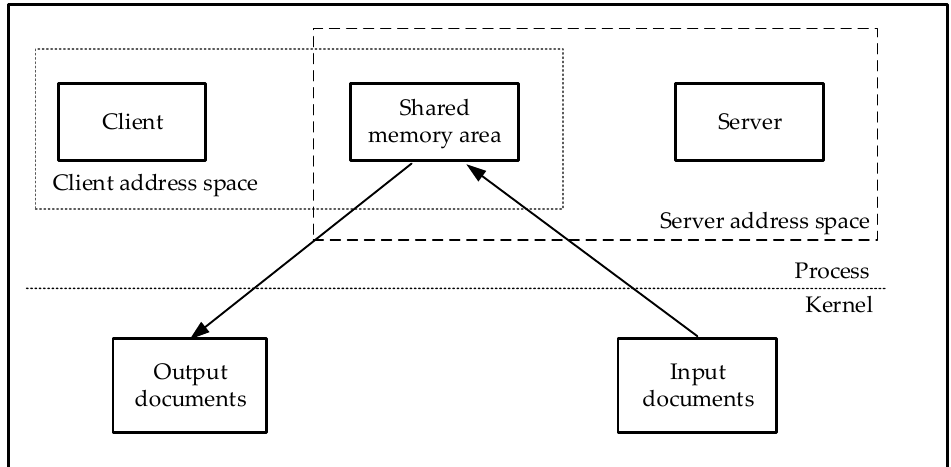
Figure 9. Shared memory between the processes.